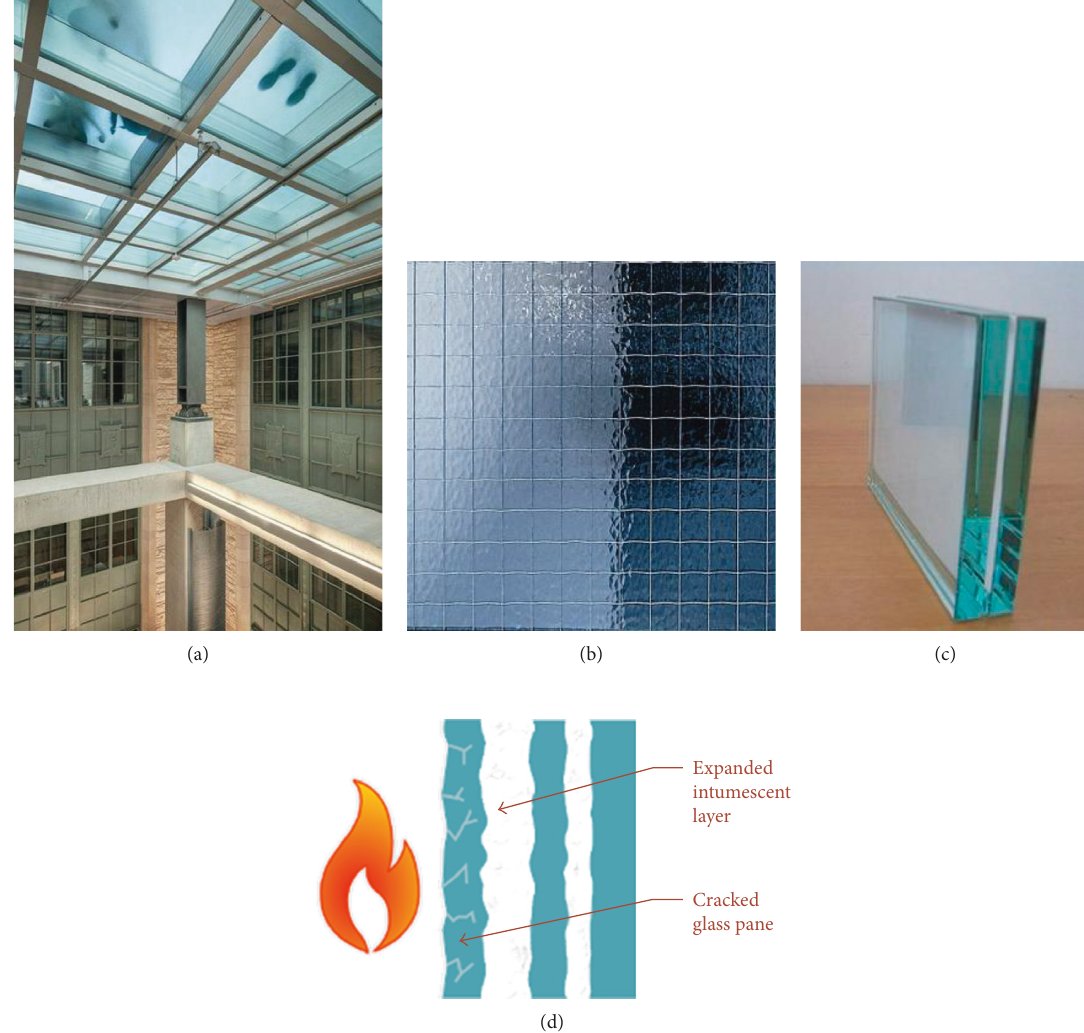
Figure 3: FR glass: (a) examples of application in a public building, (b) wired glass, (c) double LG with intumescent layer, and (d) working principle of a triple LG with intumescent interlayers (schematic cross